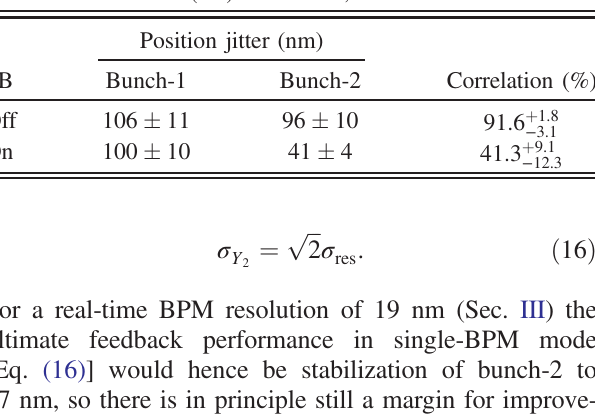
TABLE V. Position jitters and bunch-to-bunch position corre- lation with feedback (FB) off and on, for 2-BPM feedback.